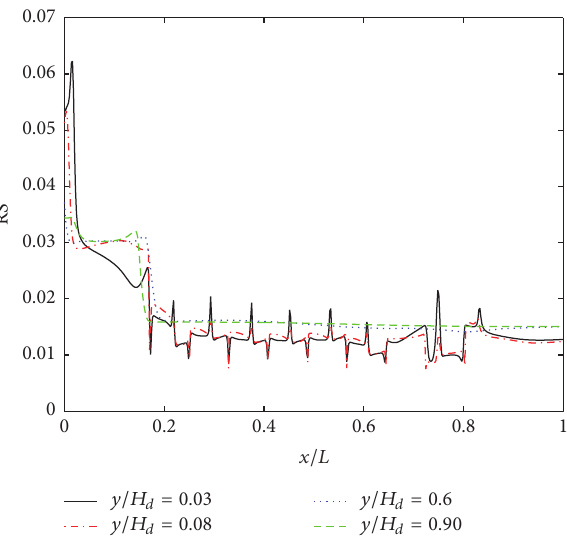
Figure 11: RS at normalized heights inside the dryer as a function of normalized distance from the entrance. The sheet is located at 𝑦 = 0 (see Figure 1).